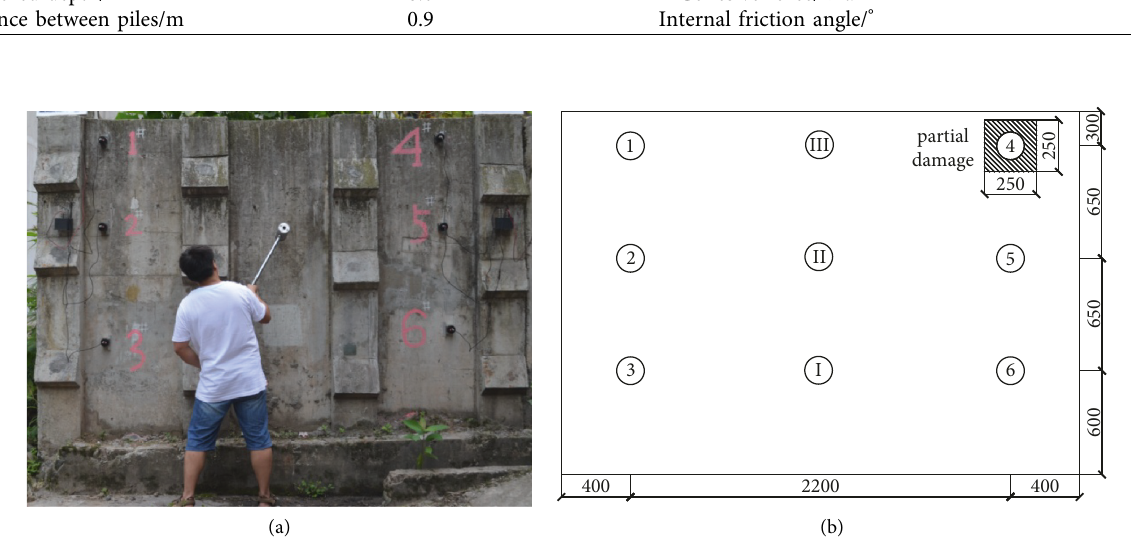
Figure 1: Vibration tests on the pile plate wind-break wall. (a) Loading impulse excitation. (b) Position of the measurement points and partial damage.